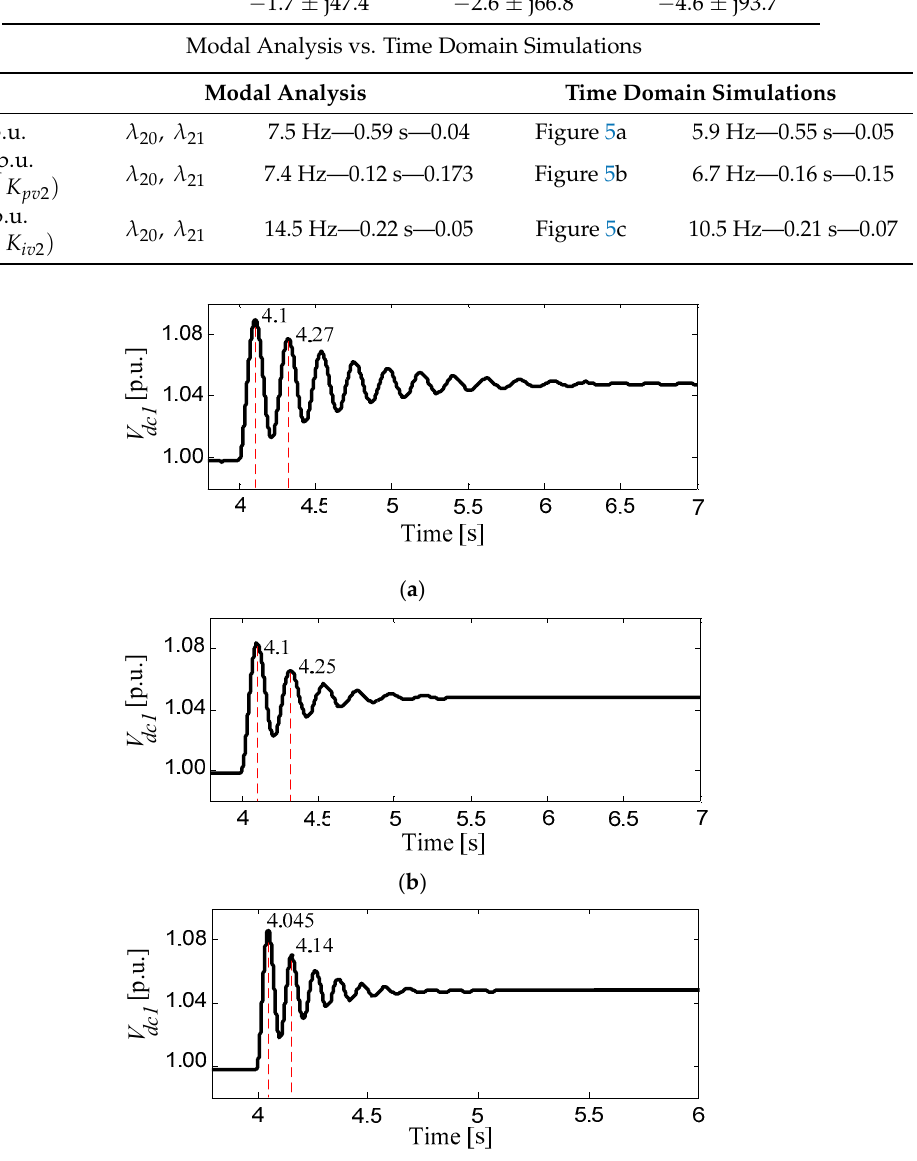
Figure 5. The dc-link voltage response of the VSC2 following a step variation in V ∗ to 1.05 p.u. at t = 4s. ( a ) K pv 1,2 = K iv 1,2 = 1 p.u. ( b ) K pv 1 = K pv 2 = 10 p.u. ( c ) K iv 1 = K iv 2 = 4 p.u.